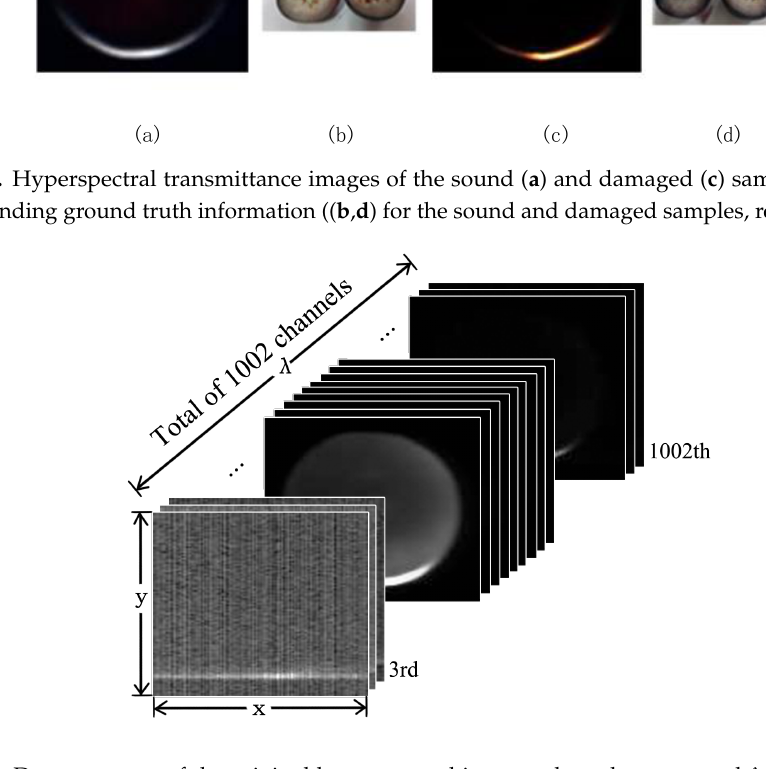
Figure 4. Data structure of the original hyperspectral image cube, where x , y and λ denote spatial x -axis, spatial y -axis, and spectral λ -axis,